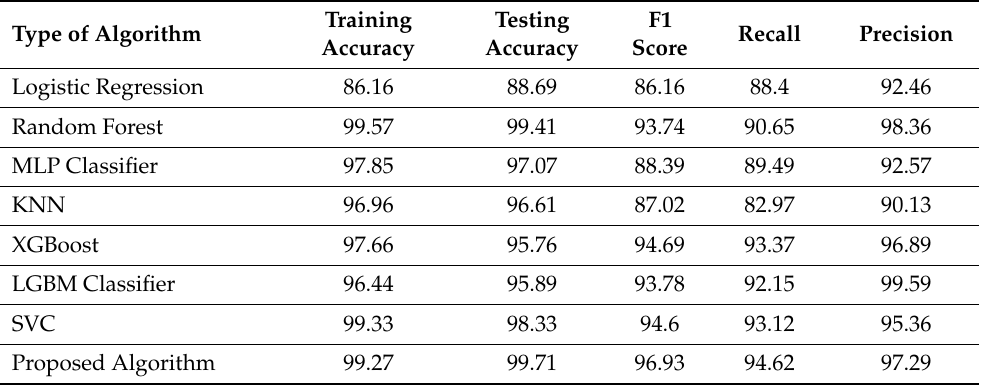
Table 2. Comparison of performance of the proposed algorithm with popular published algorithms.